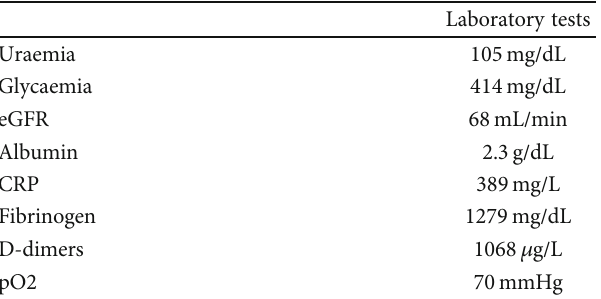
Figure 1: (a – d) Patient photos at ER presentation 13/02/2021: front (a); right side (b); inferior (c); open mouth (d). Evident swelling of the medial and inferior third of the right side of the face (a, b). Trismus, oedema of the tongue and mouth fl oor Table 1: Most relevant values of the complete blood count.